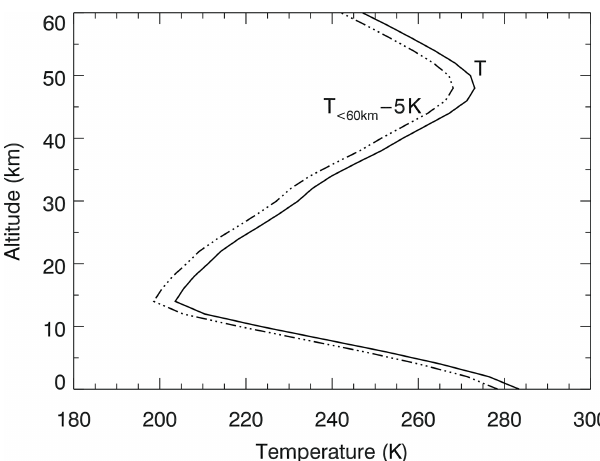
Figure 8. The temperature profiles used in the 1-D Caltech/JPL photochemical model: the baseline profile (solid line) based on the equinox zonal average at 30 ◦ latitude and the modified profile where the temperature below 60km is reduced by 5K (dashed–dotted